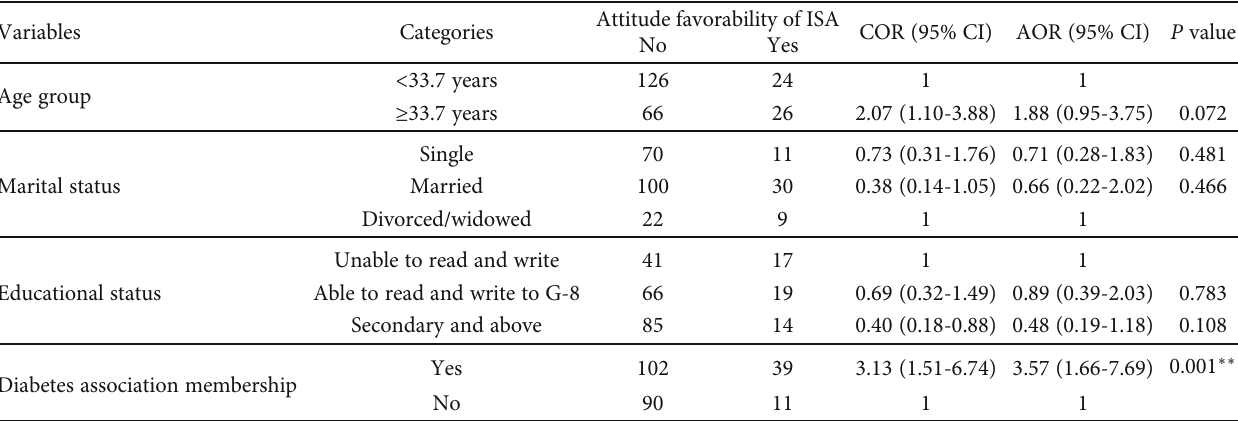
Table 5: Bivariate and multivariable logistic regression analyses of factors associated with a favorable attitude on ISA among type 1 diabetic patients at MKRH, 2019.